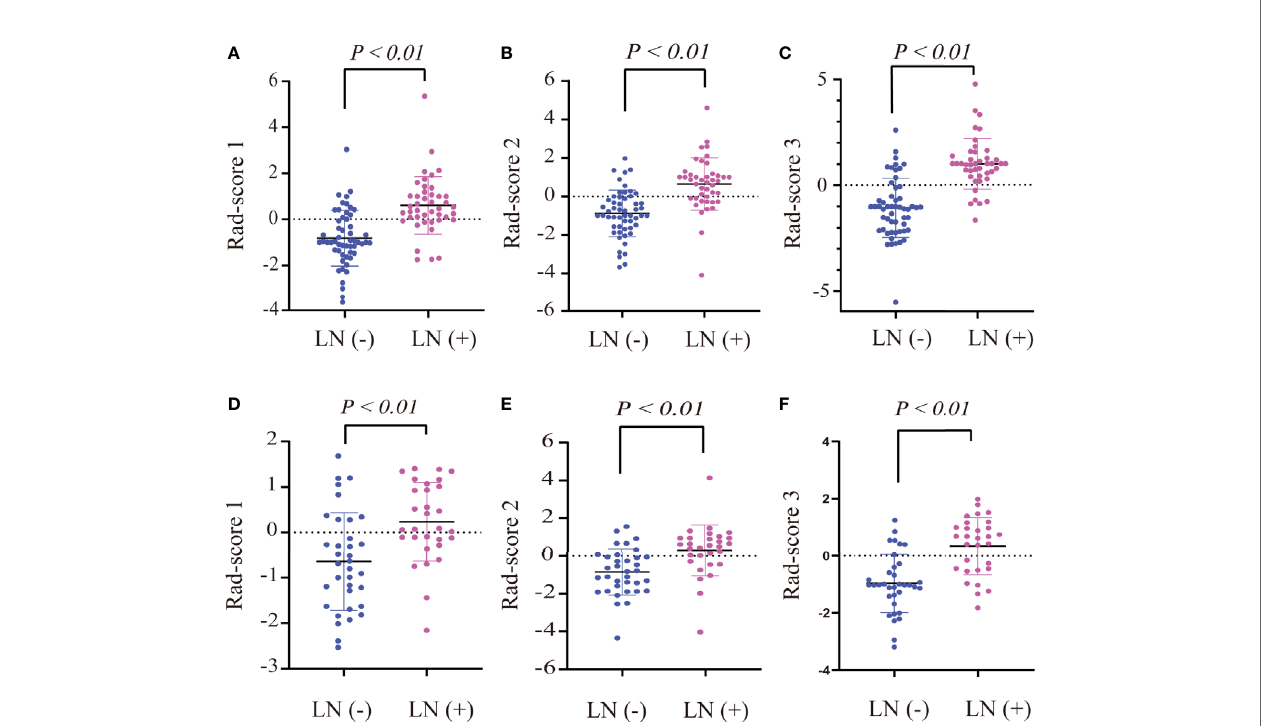
FIGURE 2 | Dot diagram of the three rad-scores in each cohort. Dot diagram of rad-score 1 in the training (A) and validation (D) cohorts. Dot diagram of rad-score 2 in the training (B) and validation (E) cohorts. Dot diagram of rad-score 3 in the training (C) and validation (F)